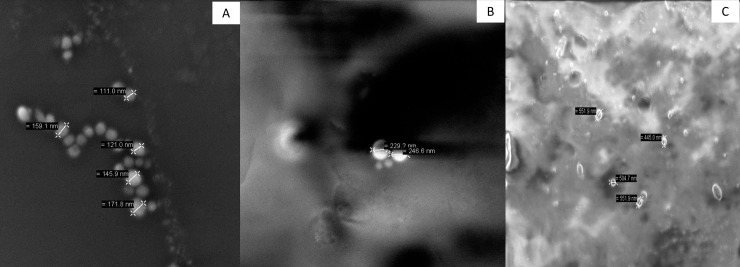
Micrographs of powdered particles, dispersed in acetone, obtained by O/W emulsification technique.(A) OG: Quinoa oil and porcine gelatin in aqueous phase 2; (B) OWG1: Quinoa oil, whey protein isolate and porcine gelatin in aqueous phase 2; (C) OWG2: Quinoa oil, whey protein isolate in aqueous phase 1, and porcine gelatin in aqueous phase 2.